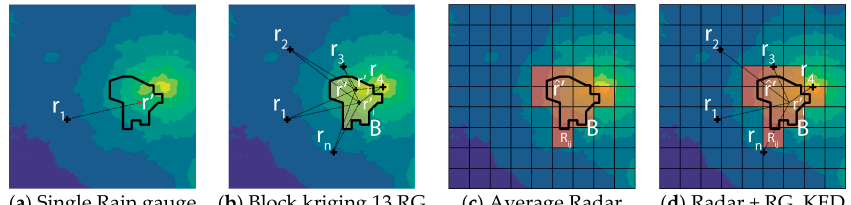
Figure 3. Rainfall estimations under change of spatial support from different data sources: ( a ) Single rain gauge data source (direct application); ( b ) Kriging estimation from n point measurements with change of block support for the area B, areal estimation ˆ r (cid:48) ; ( c ) Weighted average of radar map (R) for the area B; ( d ) Merged product between n rain gauges and the radar map through a kriging with external drift estimation under change of spatial